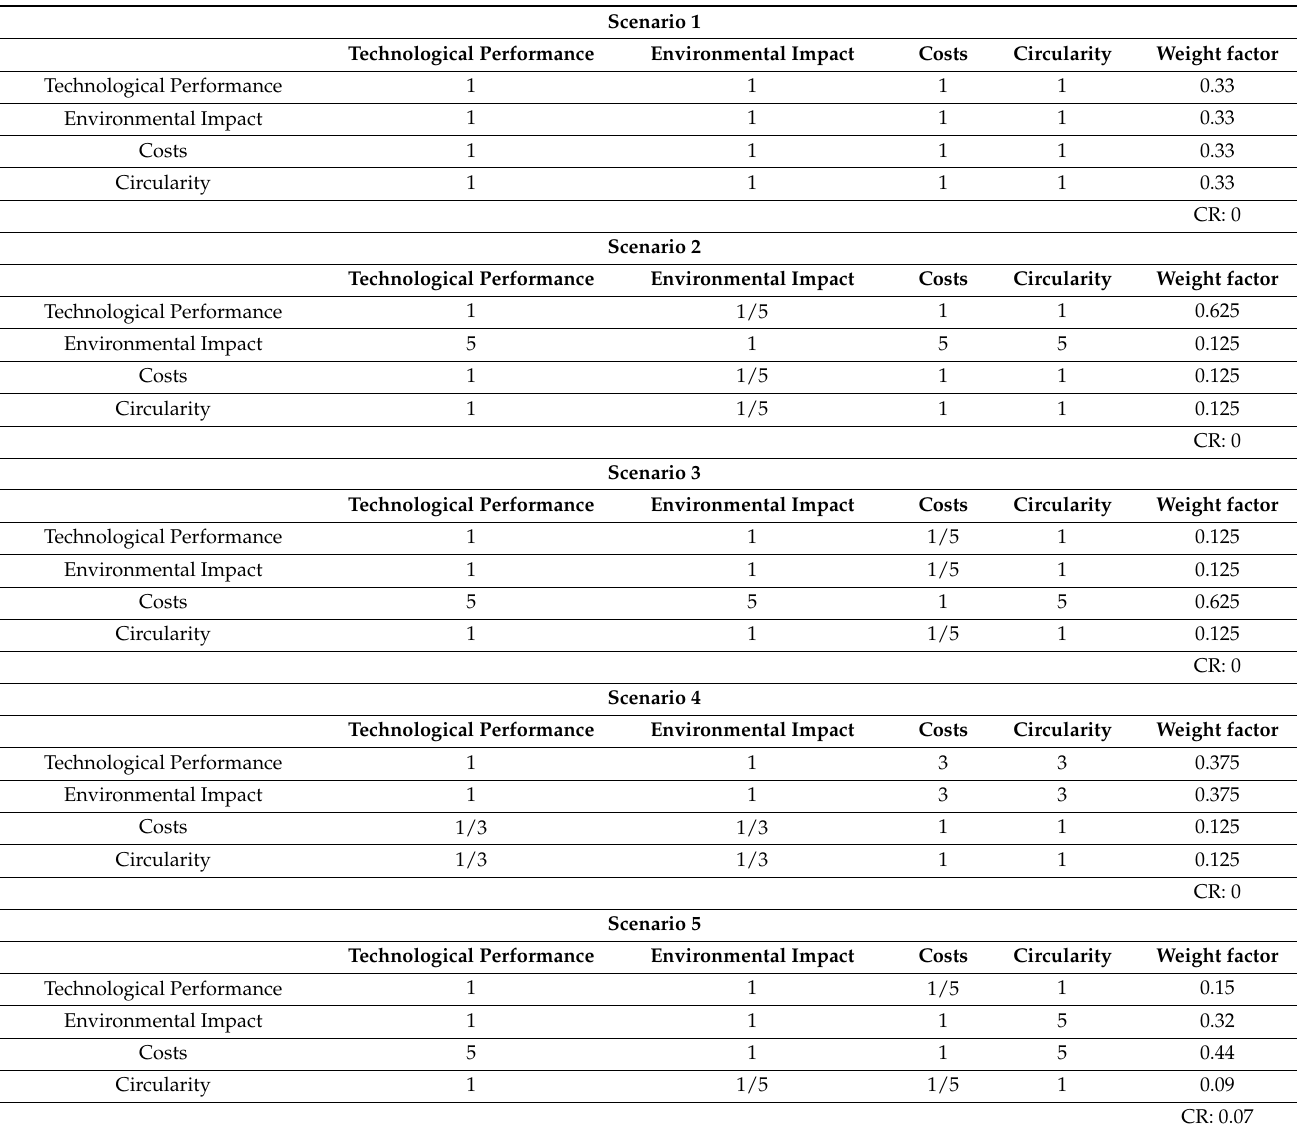
Table 3. Pairwise comparisons of the AHP